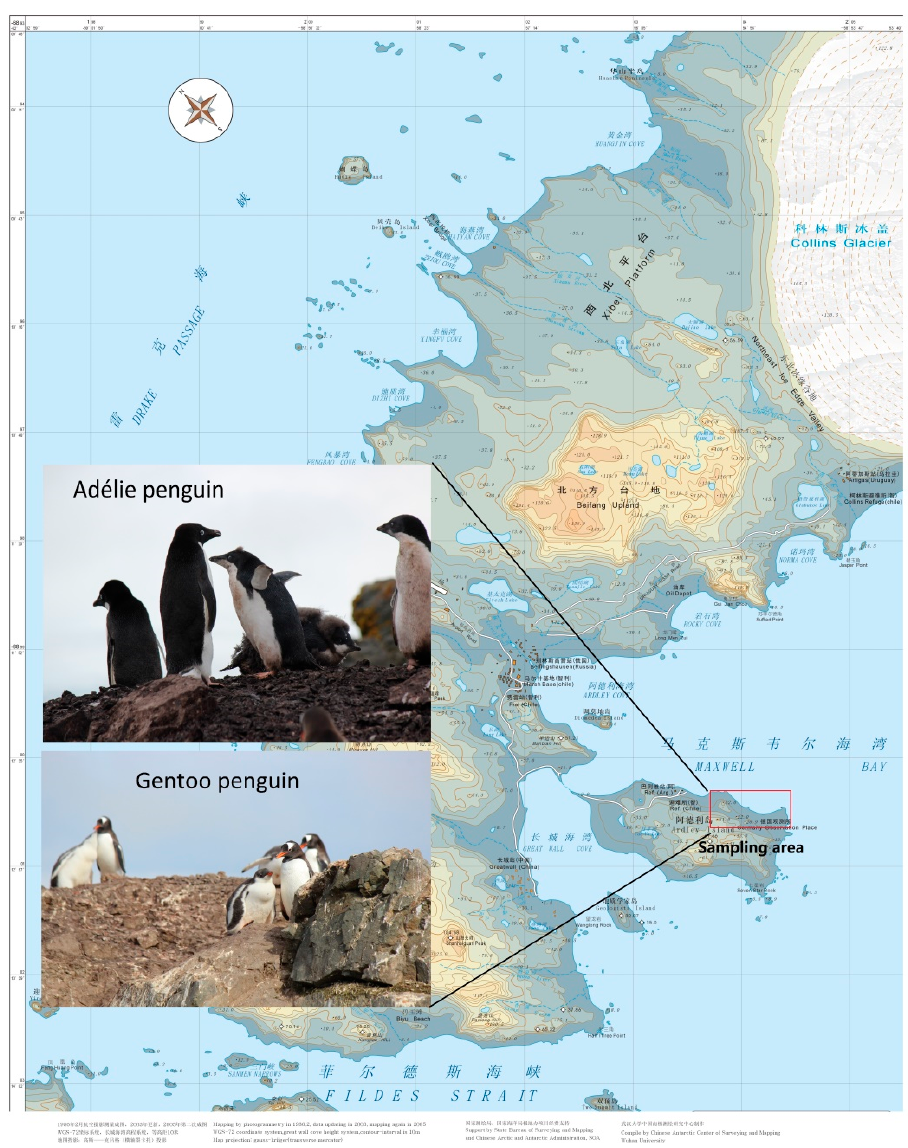
Figure 1. Map of the sampling area on the northeastern side of Ardley Island, South Shetland Islands, Antarctica, where sampling was performed in January 2019. Photos were taken by Yin-Xin Zeng.